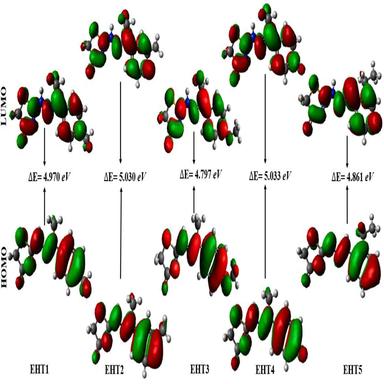
The HOMOs and LUMOs of the synthesized compounds (EHT1-EHT5).